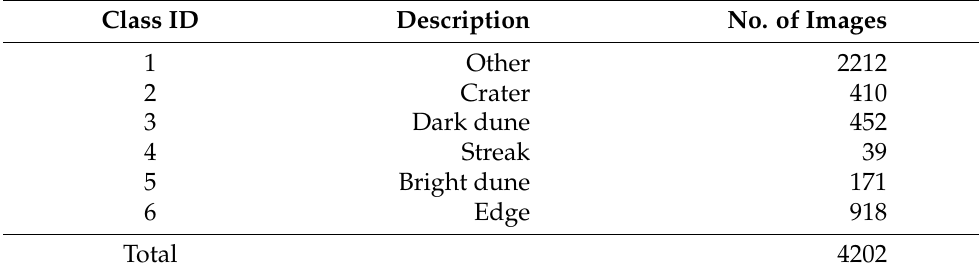
Table 4. The number of samples (images) for each label in the Deep Mars